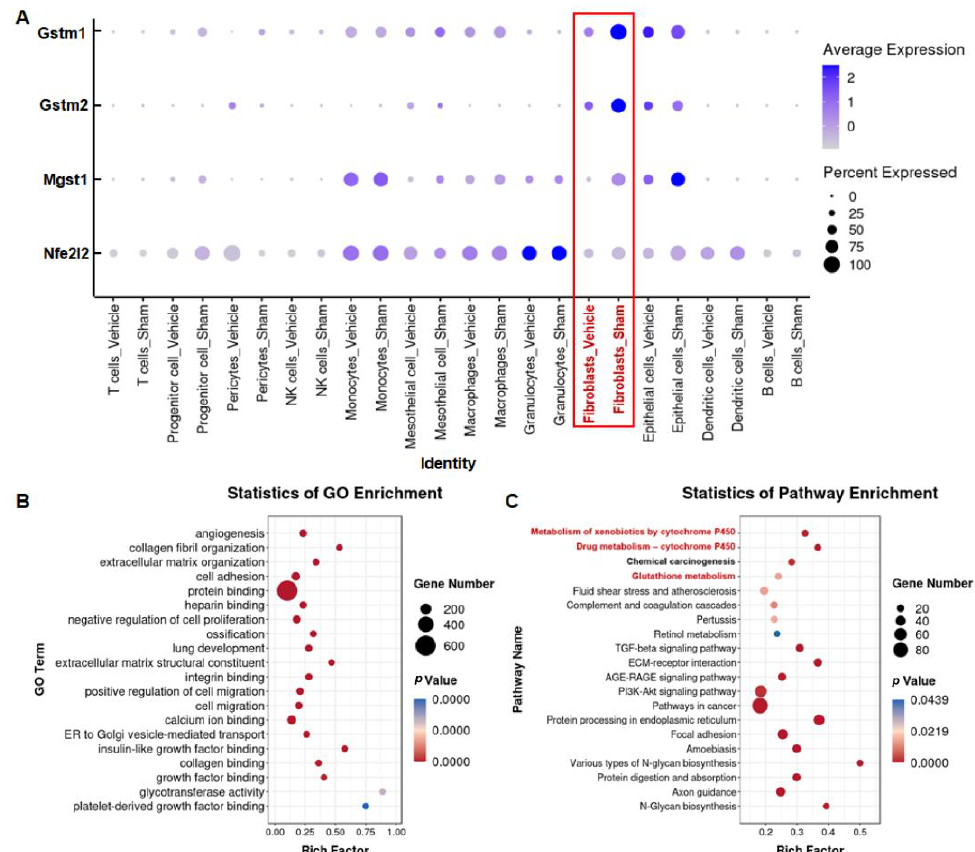
Figure 9. Silica induces oxidative imbalance in fibroblasts. ( A ) The relative expression levels of Gstm1 , Gstm2 , Mgst1 , and Nfe2l2 in different types of lung cells after silica exposure, detected by single-cell RNA sequencing. ( B ) GO analysis of fibroblasts performed using single-cell sequencing data; ( C ) KEGG analysis of fibroblasts performed using single-cell sequencing data.